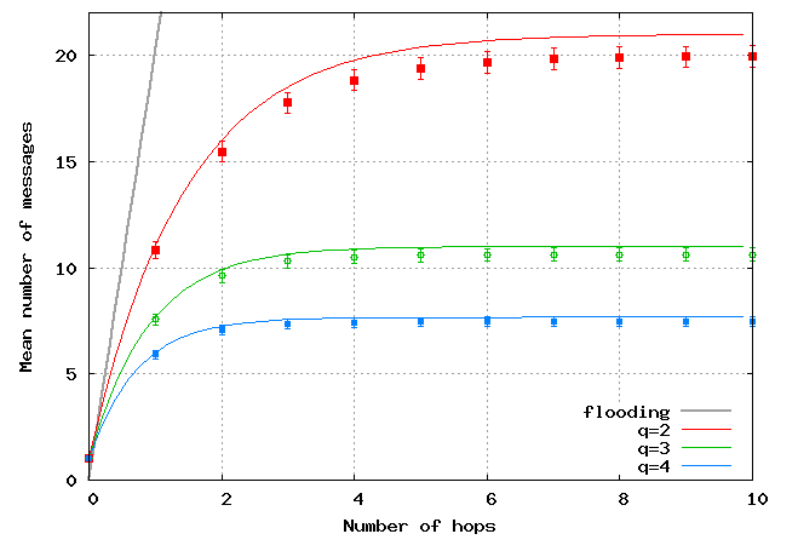
Figure 6. Mean number of messages sent per location update with respect to number of hops in 1D homogeneous network.